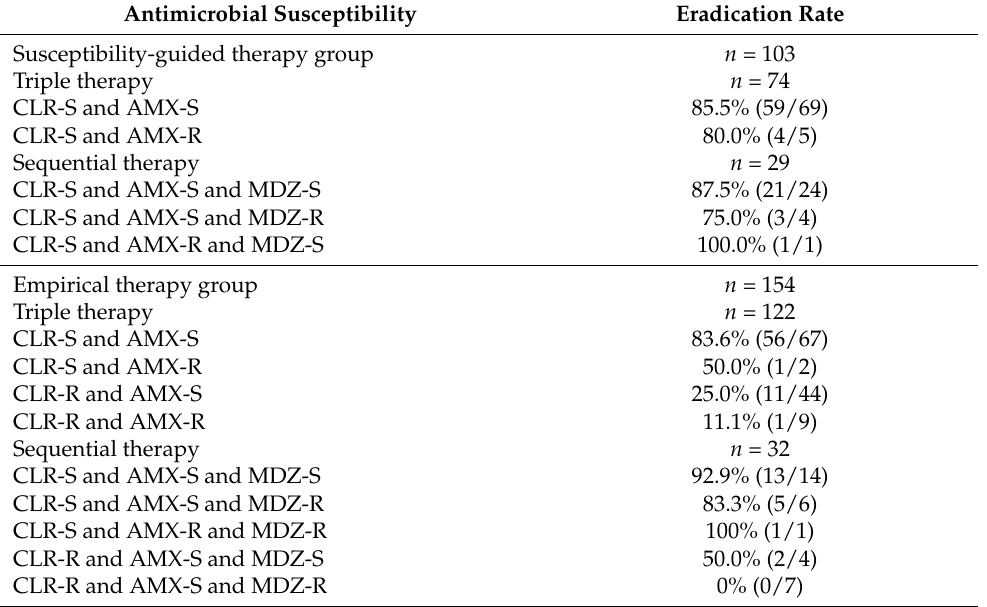
Table 4. Antimicrobial susceptibility testing results in the susceptibility and empirical therapy groups. Antimicrobial